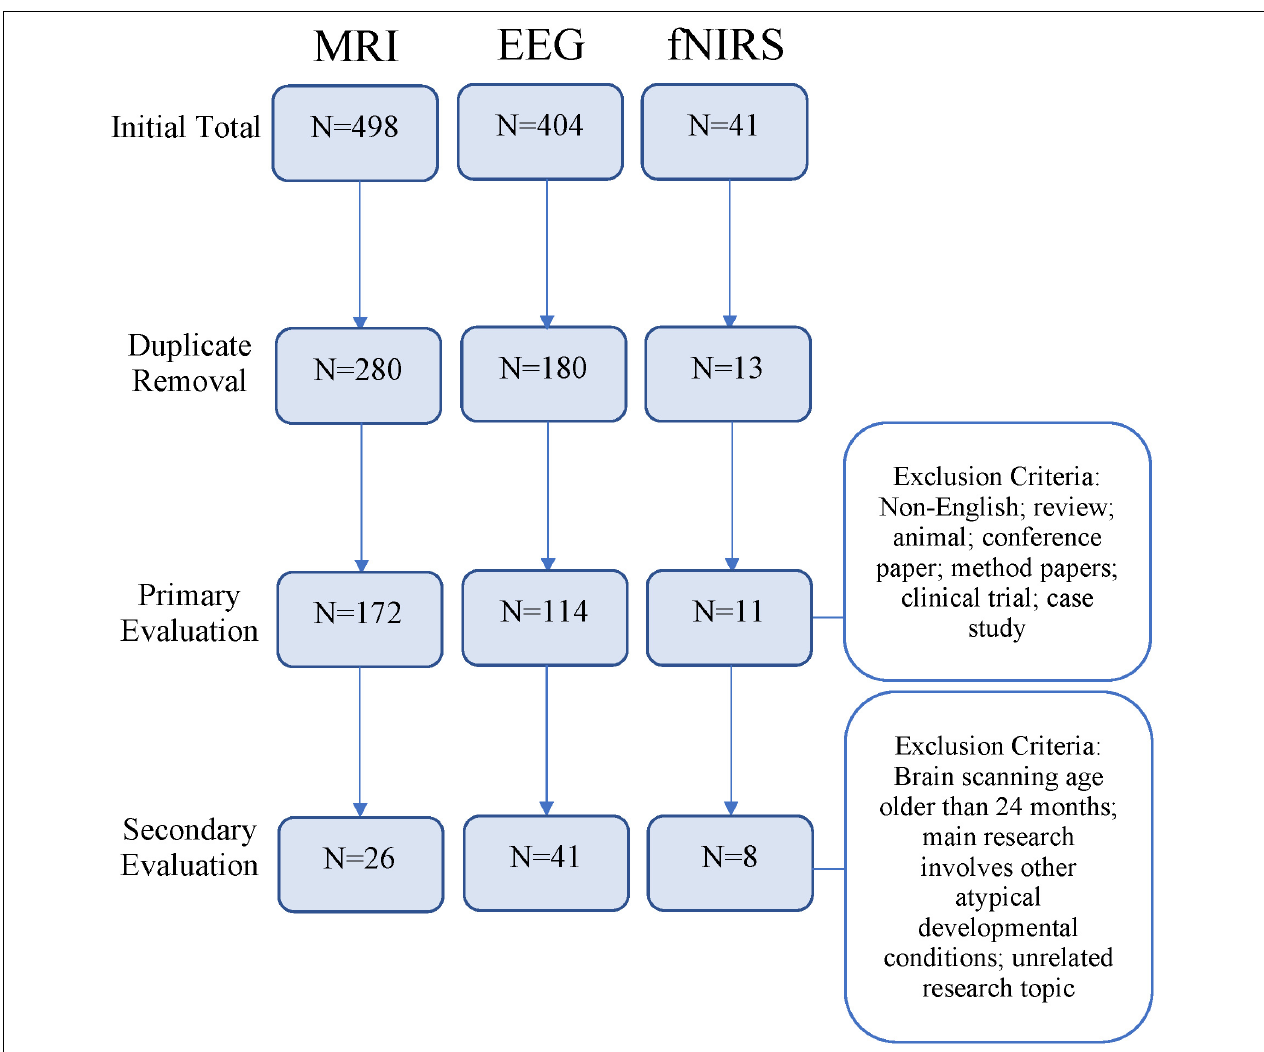
FIGURE 2 | Flowchart depicting article screening process based on research methods [magnetic resonance imaging (MRI), electroencephalogram (EEG), or functional near-infrared spectroscopy (fNIRS)].